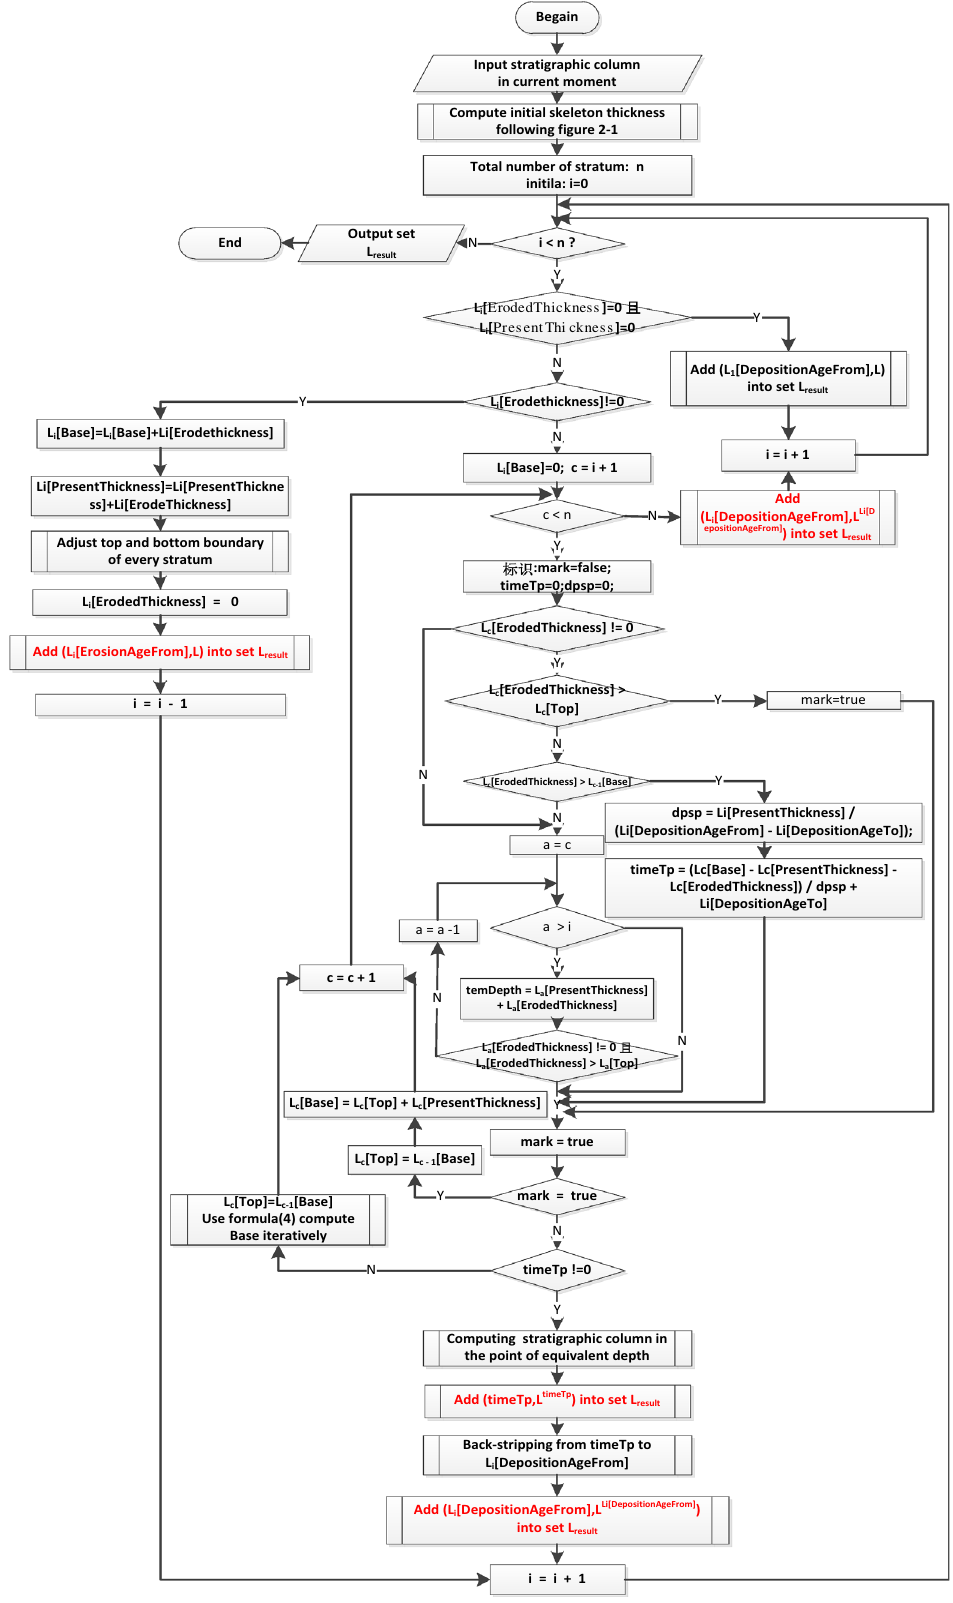
Fig. 3 Follow chart for recovering stratigraphic